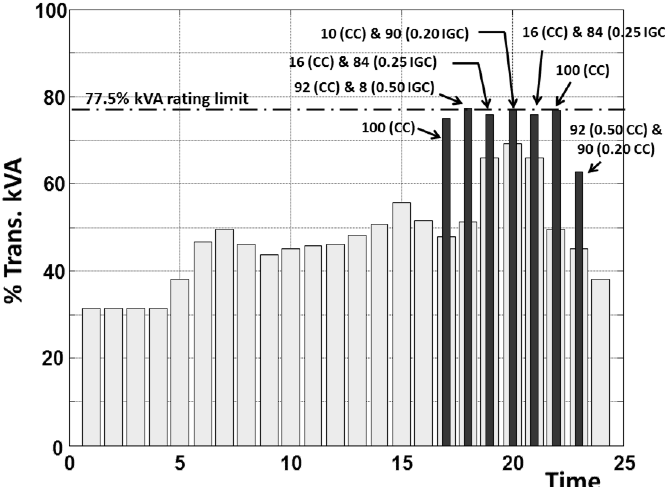
Figure 5. Distribution transformer load profile with 100% penetration of PEVs under smart